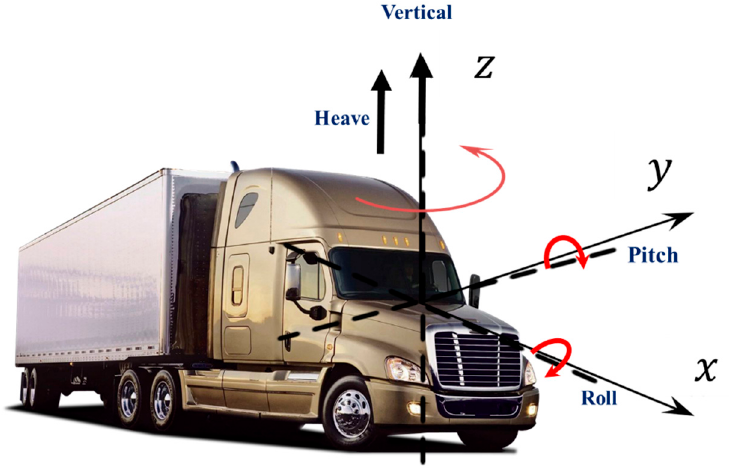
Figure 14. Pitch, roll and heave in Cab [97].